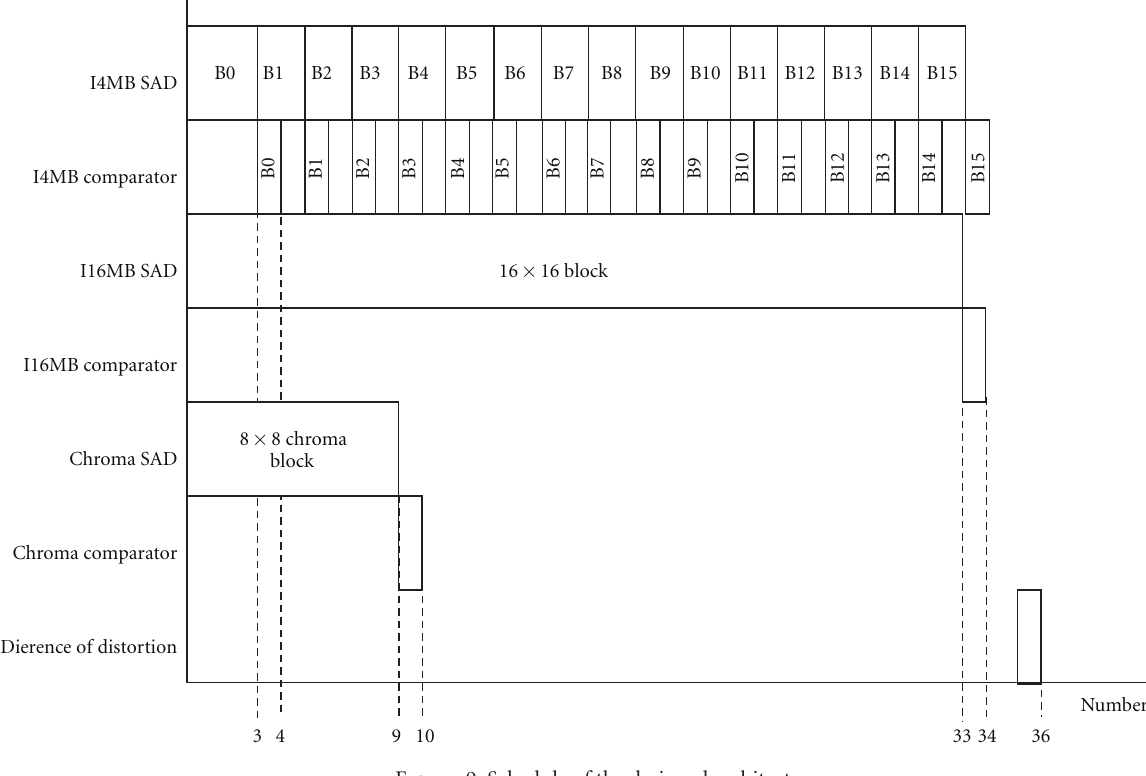
Figure 9: Schedule of the designed